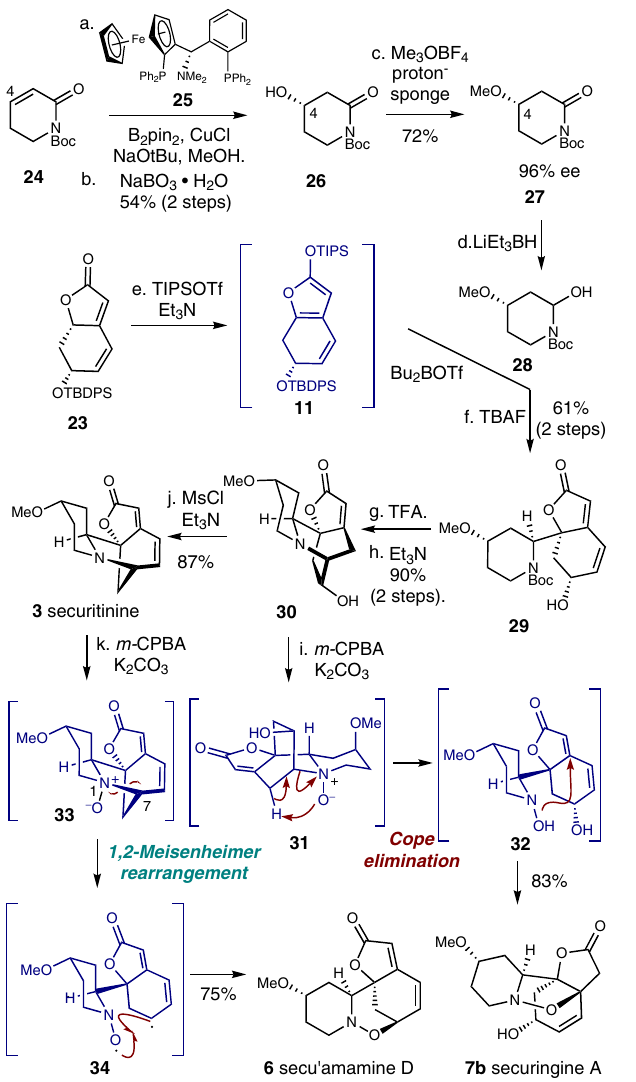
Fig. 4 | Total synthesis of secu ’ amamine D (6) and securingine A (7b) via divergent 1,2-Meisenheimer rearrangement and Cope elimination. Reagents and conditions: (a) B 2 pin 2 (1.1 equiv), CuCl (0.02 equiv), NaO t Bu (0.03 equiv), 25 (0.04 equiv), MeOH (2.0 equiv), THF, 23°C; (b) NaBO 3 ·H 2 O (5.0 equiv), THF:H 2 O (1:1 v / v ), 23°C, 54% (2 steps); (c) Me 3 OBF 4 (3.0 equiv), proton-sponge (4.0 equiv),